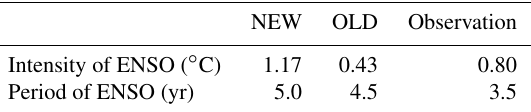
Table 2. The intensity and period of ENSO in NEW, OLD, and the observations calculated from the 1-year running mean NINO3-SST anomalies for the period from 1961 to